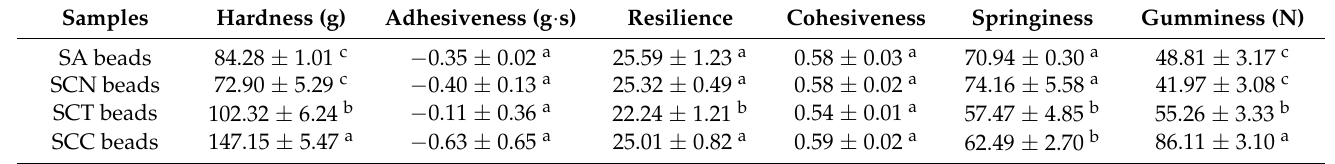
Table 3. Texture profile analysis of